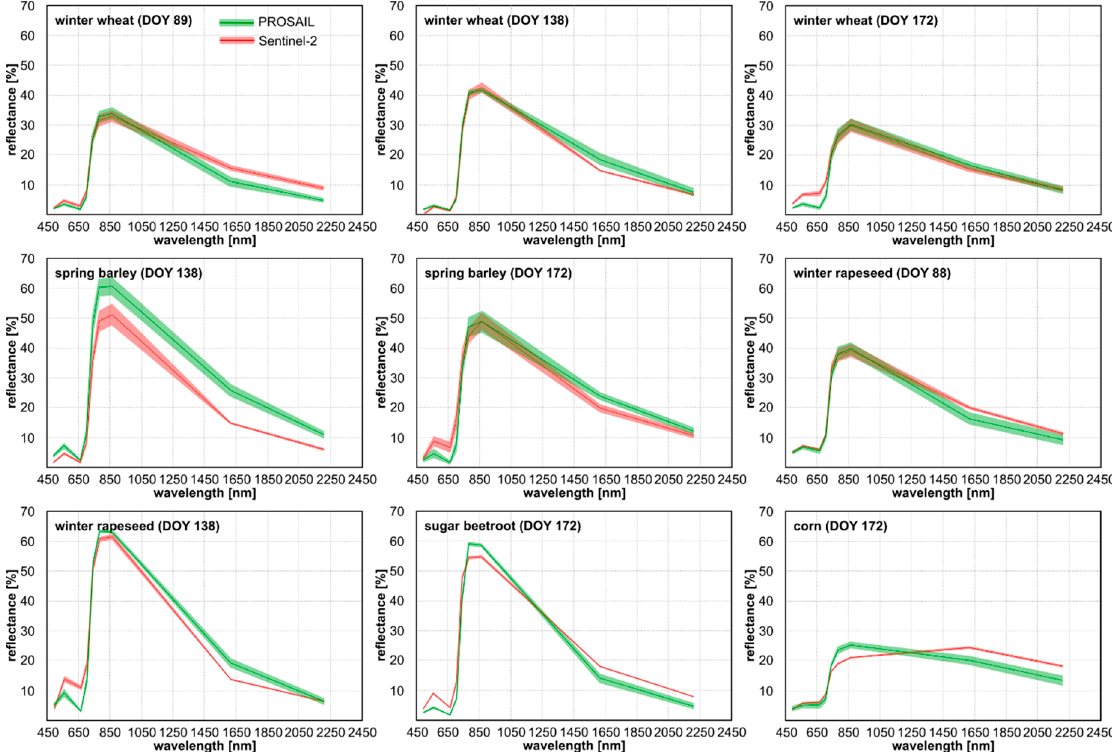
Figure A3. Sentinel-2 spectra and PROSAIL simulations for the different development stages of crops of interest.